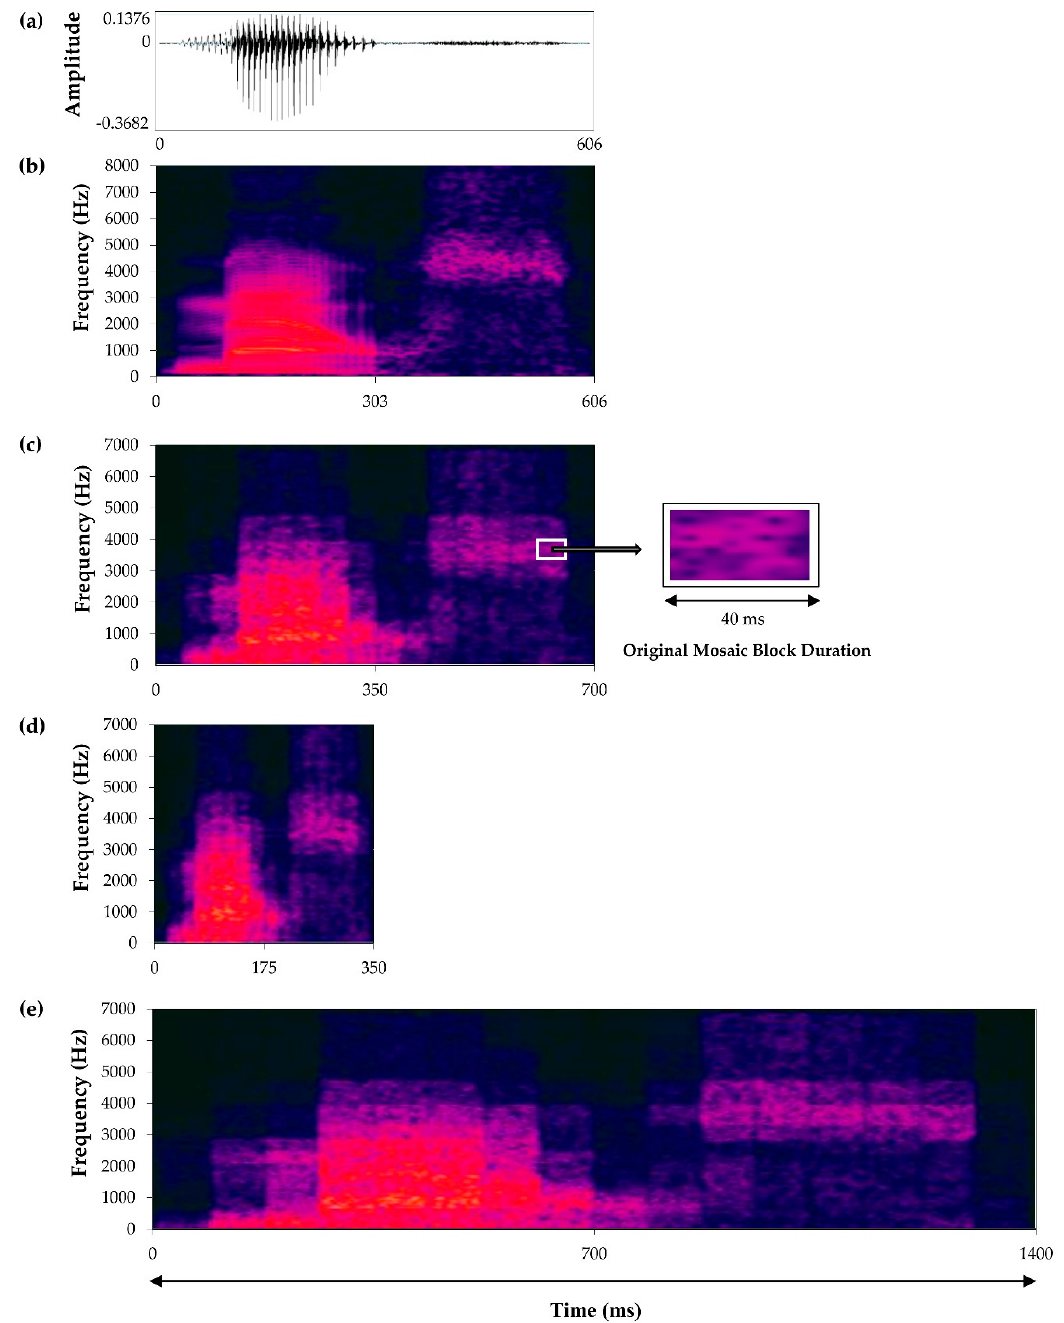
Figure 1. Examples of the mosaic speech stimuli used in this study. ( a ) The waveform and ( b ) the spectrogram of the original speech for the word “mouse”, pronounced by a male native-English speaker. ( c ) An example of mosaic speech with an original mosaic block duration (OMBD) of 40 ms. Each individual block consisted of one mosaic block duration on the horizontal axis and one frequency band on the vertical axis. ( d ) An example of compressed mosaic speech with an OMBD of 40 ms compressed into a mosaic block duration (MBD) of 20 ms. ( e ) An example of stretched mosaic speech consisting of an OMBD of 40 ms stretched into an MBD of 80 ms.